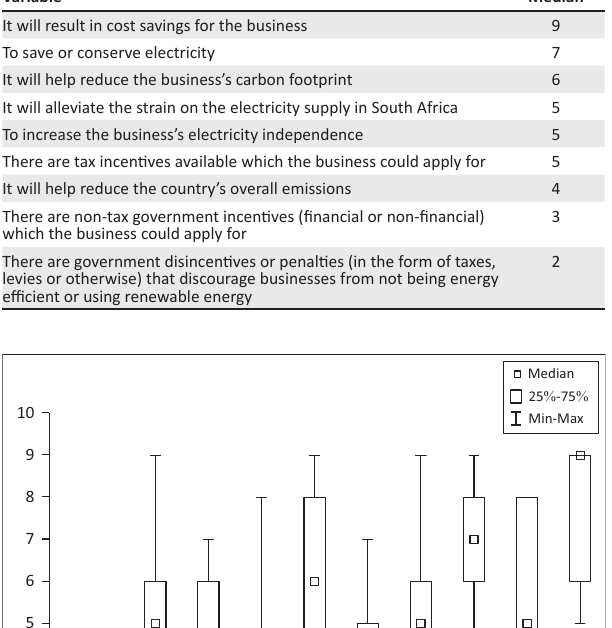
TABLE 5: Order of importance of factors that potentially play a role in decisions. Variable